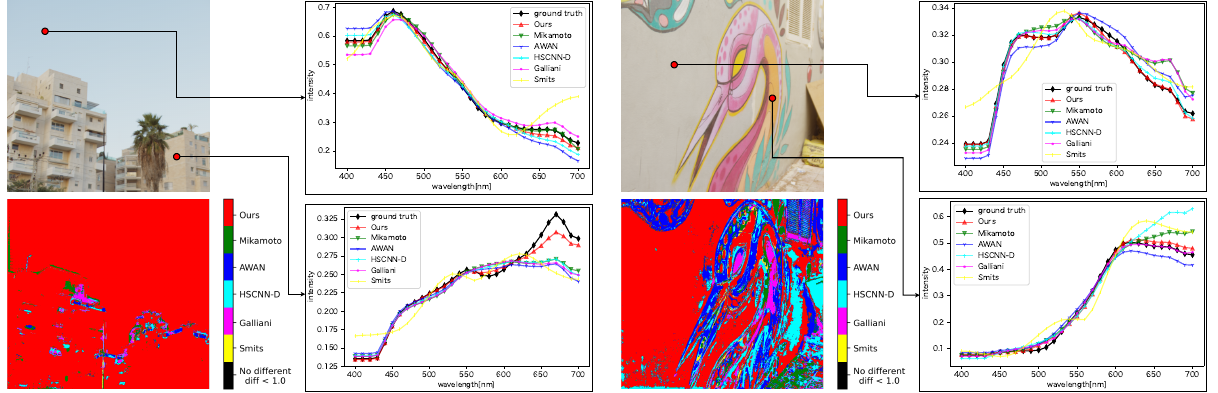
Figure 9. Qualitative evaluation of each method on the ARAD HS dataset. For each sub-figure, the upper left is the input image, the lower left shows the most accurate method for each pixel based on the evaluation metric SAM, and the upper right and lower right plot the spectral distributions for the selected